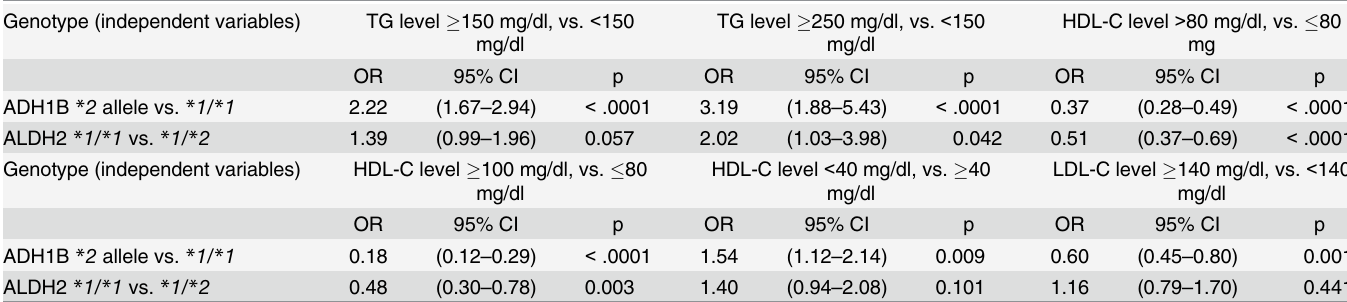
Table 4. Multiple logistic regression analysis of dyslipemia in Japanese alcoholic men according to their ADH1B and ALDH2 genotypes after adjustment for other independent variables. Genotype (independent